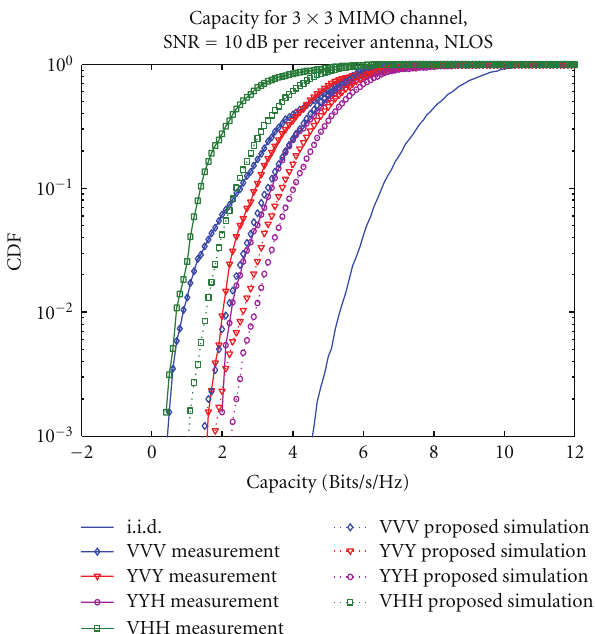
Figure 9: The plots of CDF versus capacities obtained by mea- surement analysis (solid line), proposed simulation analysis (dotted line) for dissimilar polarization systems in indoor NLOS environ-